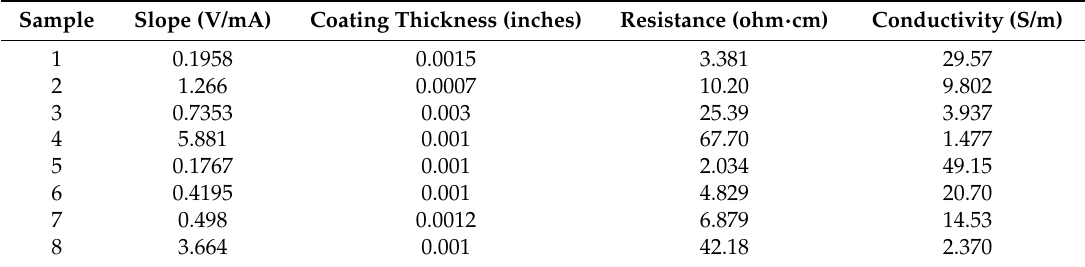
Table 3. Electronic conductivity measurements with different composition ratios of LiMn 2 O 4 composite electrode samples.